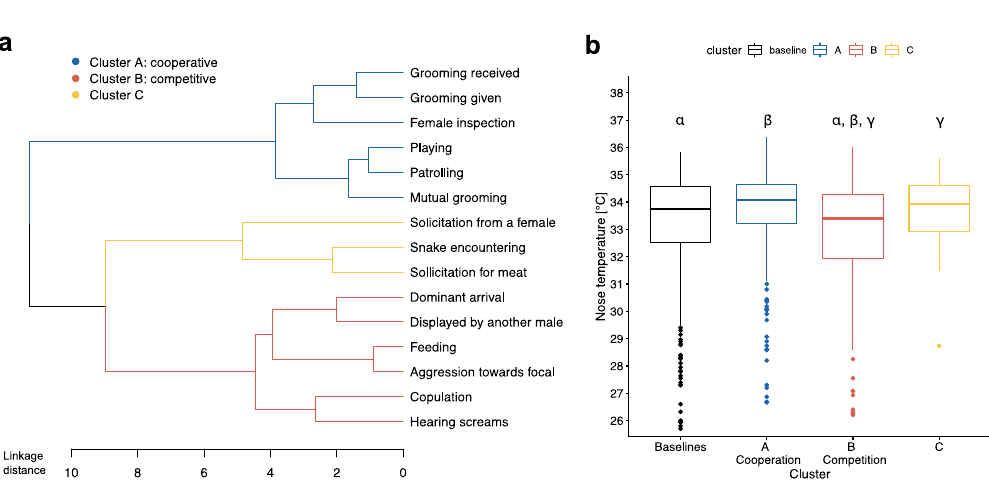
Figure 1. Results of cluster analysis of the events based on the nose temperature pattern. ( a ) Cluster analysis of events based on ( b ). Recorded nose temperatures during these events (n = 1003). The analysis revealed a segregation between cooperative (in blue, cluster A) and competitive events (in red, cluster B), as well as a cluster comprising events involving both cooperative and competitive aspects (in yellow, cluster C). The analyses showed differences between baselines and competitive events (‘α’, p = 0.056), between cooperative and competitive events (‘β’, p < 0.001) and between competitive events and cluster C (‘γ’, p = 0.064). The recorded nose temperatures for each event are shown in Supplementary Fig.